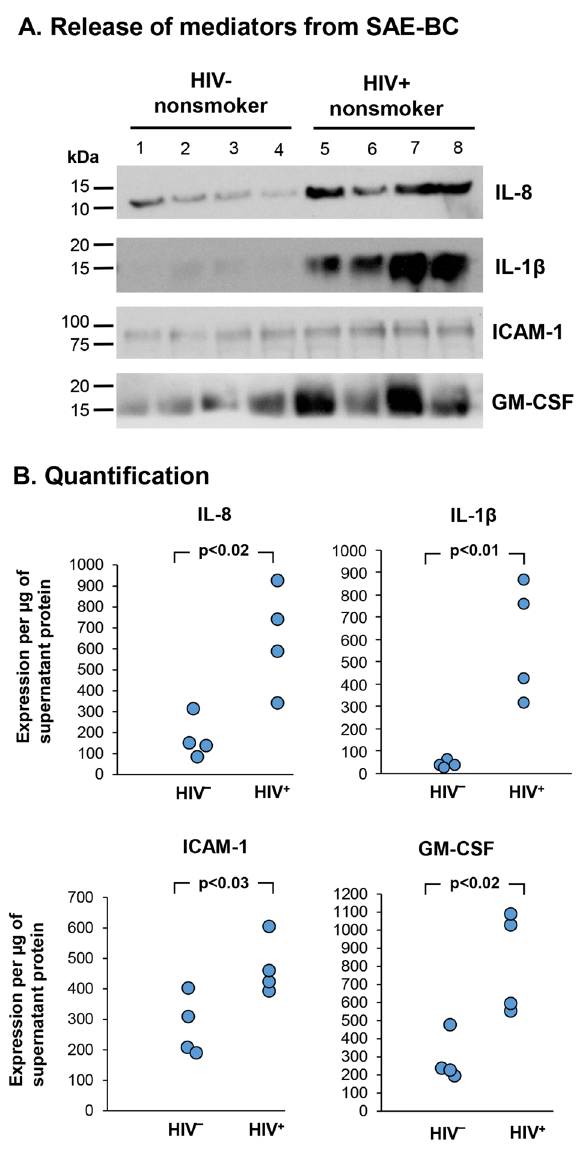
Figure 1. Small airway BC from HAART-treated HIV + nonsmokers are induced to release inflammatory mediators in vivo. Small airway BC (5 × 10 5 in 1 ml) from 4 HIV - and 4 HIV + nonsmokers (all with viral load < 20 copies/ml) were plated onto type IV collage-coated 6-wells and incubated for 2 days. Culture supernatants were collected for assessment of cytokine release. ( A) Western analyses of IL-8, IL-1β, GM-CSF and ICAM-1 from HIV - (lanes 1–4) and HIV + nonsmokers (lanes 5–7). The original images of full-length immunoblot for each cytokine were shown in Supplemental Fig. 1. ( B) Quantification of IL-8, IL-1β, GM-CSF and ICAM-1 release by small airway BC. Western analysis from HIV ‾ and HIV + small airway BC (n = 4 for each group) were quantified by ImageJ software and normalized with the total amount of supernatant protein as densitometry (pixel intensity) per µg of supernatant